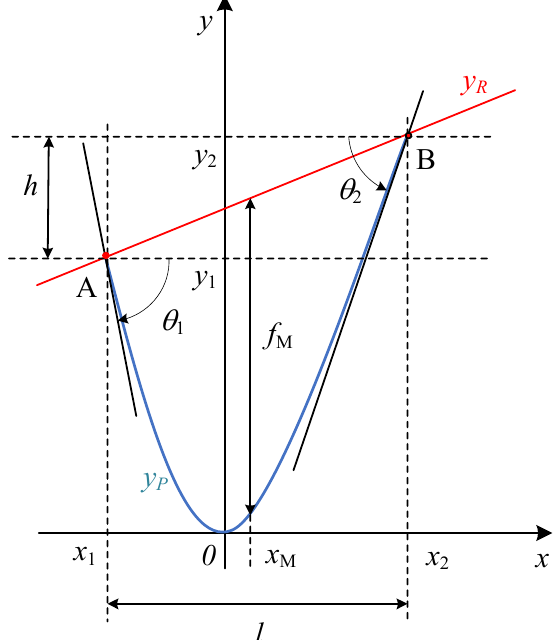
Figure 1. Schematization of the span with unequal level supports with a parabolic function. Angles are positive when describing a counterclockwise rotation.